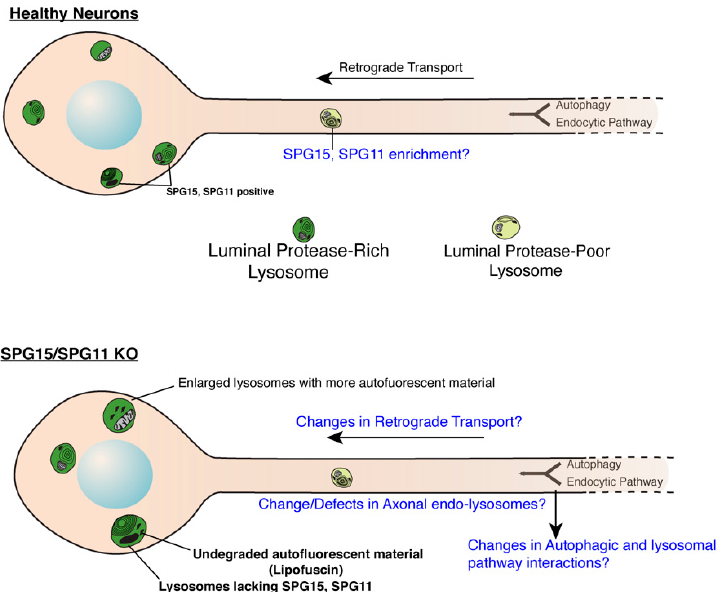
Figure 1. Role of SPG11 and SPG15 in regulating endo-lysosomes in neurons. Cartoon showing endo-lysosomes in healthy or SPG11/SPG15 KO neurons. SPG11 and 15 localize to late endosomes and lysosomes in soma of healthy neurons while they are lacking in the KO neurons. Lysosomes in KO neurons are enlarged and accumulate autofluorescent, undegraded material called lipofuscin. It remains to be investigated if SPG11/15 localize to axonal lysosomes even in healthy neurons. Likewise, effect of SPG11/15 loss on aspects of axonal lysosomes (such as their transport, composition and interaction with autophagosomes) remains to be investigated. Open questions are indicated in blue (Cartoon modified from Gowrishankar et al., PNAS, 2015) [56].